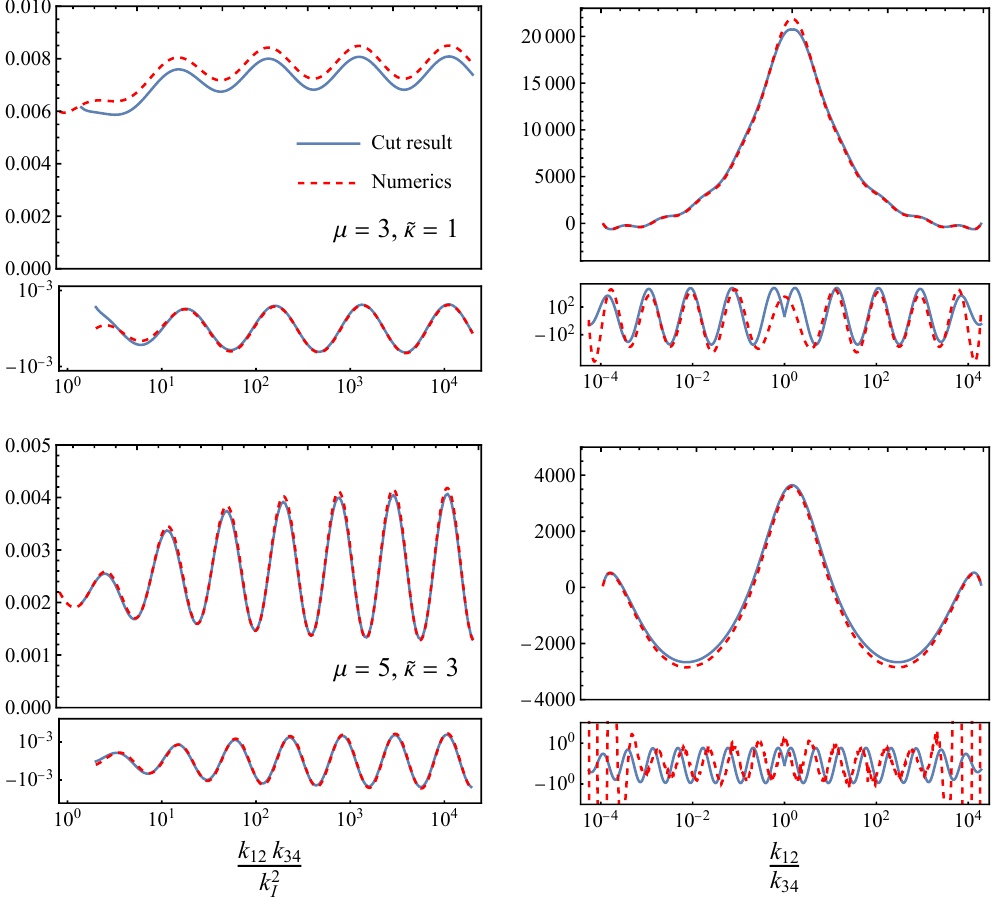
Figure 10 . The CC signals in the h ζ 4 i for different combinations of mass µ and chemical potential ˜ κ . Left column: the non-local type CC signal (oscillations in k 12 k 34 /k 2 malization k 9 h ζ ( k 1 ) ζ ( k 2 ) ζ ( k 3 ) ζ ( k 4 ) i 0 / 8 H 10 and momentum configuration k 1 = k 2 = k 3 = k 4 , s 1 M 2 ˙ φ 4 0 ψ I = 0 . Right column: the local type CC signal (oscillations in k 12 /k 34 ), with normaliza- tion k 6 k 6 k − 3 h ζ ( k 1 ) ζ ( k 2 ) ζ ( k 3 ) ζ ( k 4 ) i 0 / H 10 and momentum configuration k 1 = k 2 , k 3 = k 4 , s 1 3 I M 2 ˙ φ 4 0 k 12 k 34 = 2 × 10 4 , ψ I = 0 . The upper panels show the full result while the lower panels show k 2 I the oscillatory CC signal only, with the blue solid lines representing the analytical cut result and the red dashed line representing that from numerical results (the signals are filtered from the total numeric integration result using high-pass filters with a Blackman window